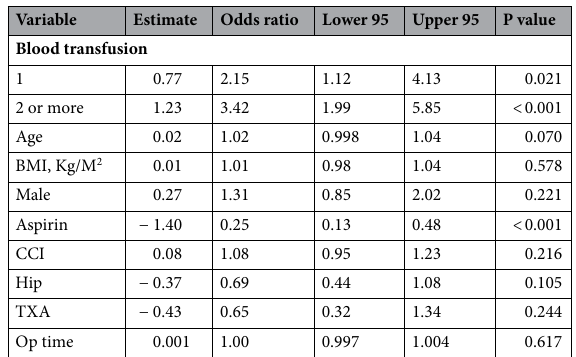
Table 5. Logistic mixed model regression evaluating the association between 1 blood transfusion, or 2 or more (with zero transfusions as the reference) and risk for VTE in the revision TJA cohort. BMI Body